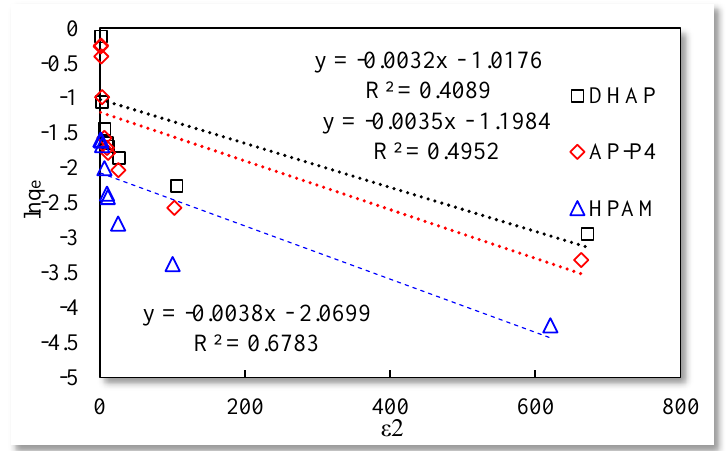
Figure 6. Dubinin − Radushkevich isothermal adsorption model.